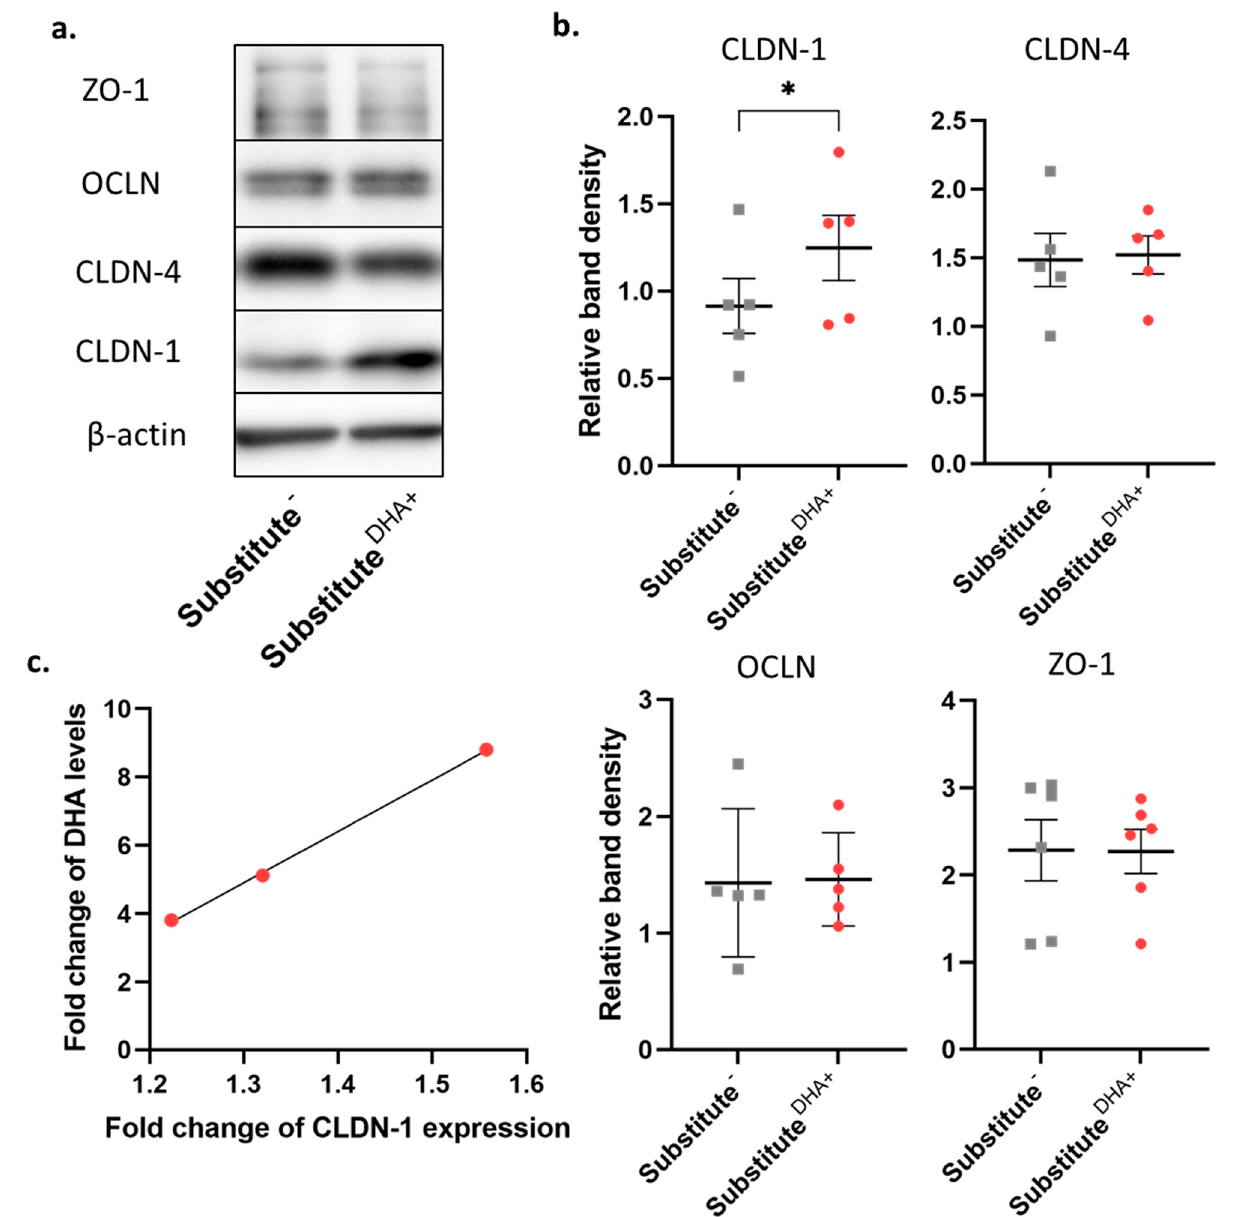
Figure 5. Levels of TJ proteins found in the epidermis of skin substitutes. ( a ) TJ molecules Cldn-1, Cldn-4, Ocln, and ZO-1 were analyzed by Western blotting. ( b ) Signals for relative band densities were quantified using ImageJ Software. n = 5, p -values were derived from Student’s t -tests and considered statistically significant when * p -value < 0.05. ( c ) Correlation between fold change of DHA levels and fold change of Cldn-1 in skin substitutes. Abbreviations: Cldn-1, claudin-1; Cldn-4, claudin-4; NHS, normal human skin; Ocln, occludin; ZO-1, tight junction protein-1.